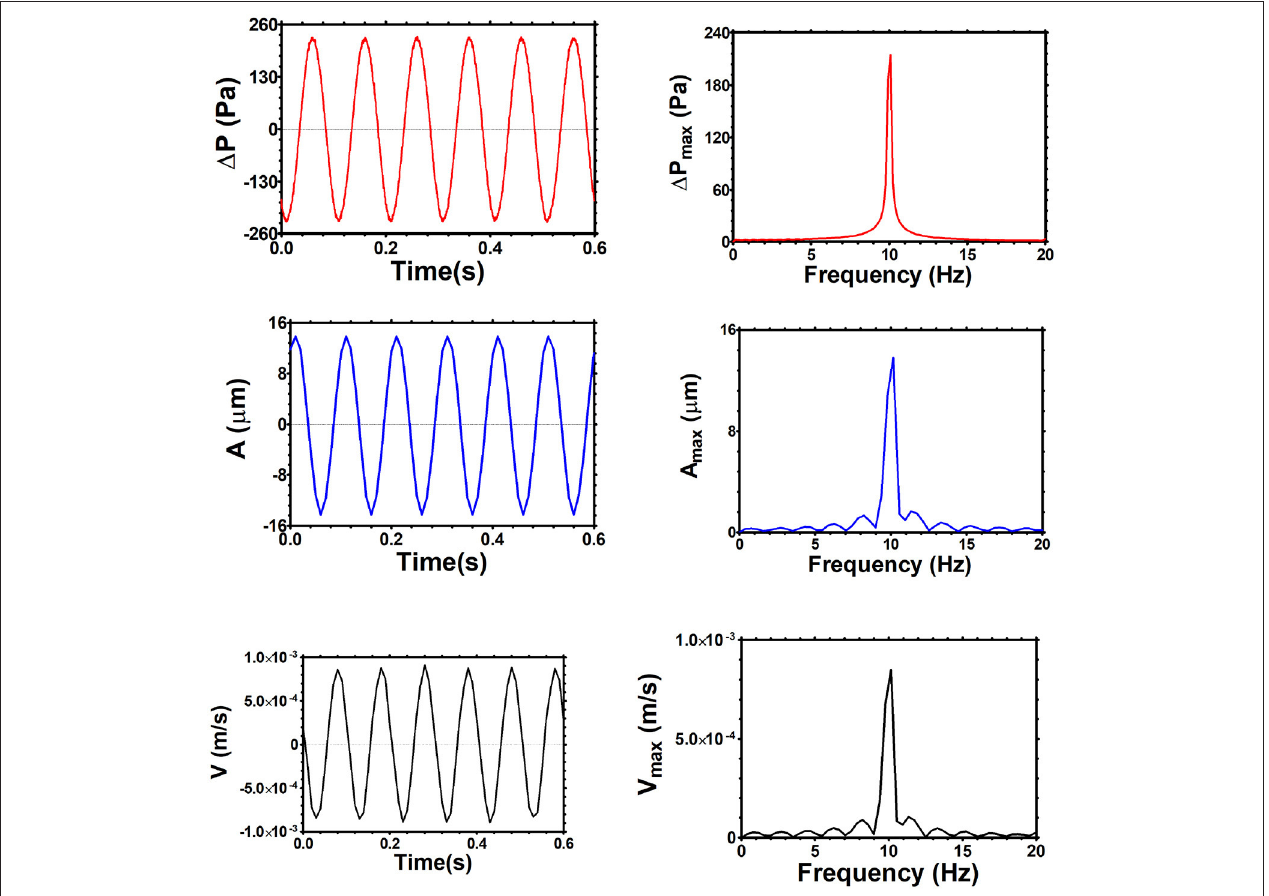
FIGURE 3 | Left : pressure drop, interface displacement, and interface velocity as a function of time for the same experiment. Right : Fourier spectrum analysis of the corresponding quantities, showing that all of them have a dominant mode for their dynamics at 10 Hz. Data are for PEO5 0.1%, 1 p = 225 Pa .